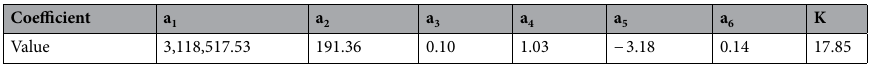
Table 4. Computed coefficients for SASS method. a 1–6 coefficients; K